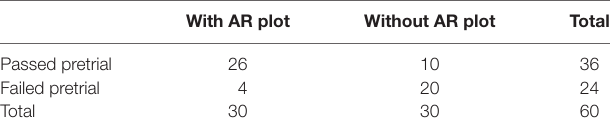
Table 1 | The performance of participants in the pretrial, with and without access to the augmented plot. With ar plot Without ar plot